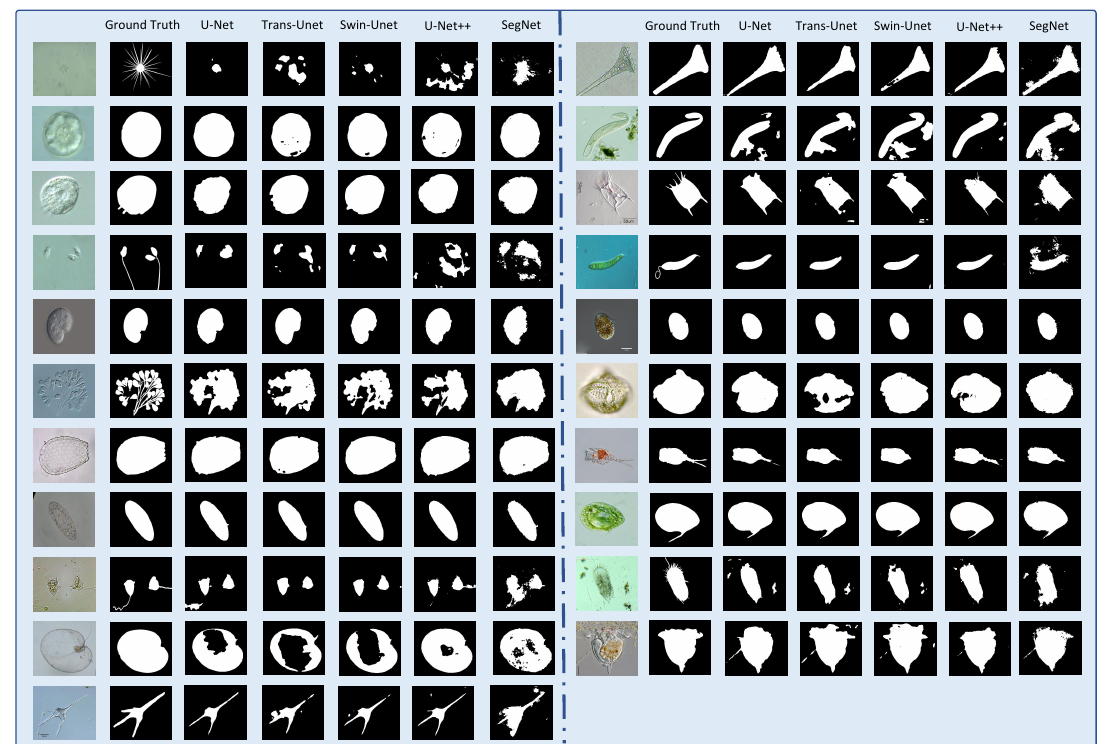
Figure 13. Reconstruction of pixel-level segmentation results on transparent images the EMDS-6 test set. (The figure contains the original image, ground truth image and U-net, Trans-Unet, Swin-Unet, U-Net++, SegNet network model predicted segmentation results).